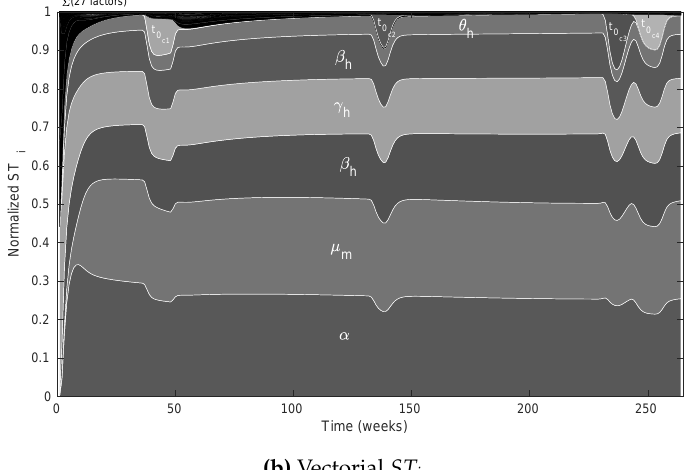
Figure 5. Sensitivity analysis for the dengue model with four pulse-type inputs for case C (with 1% uncertainty in each nominal parameter), using ( a ) scalar and ( b ) vectorial ST i indices from the Saltelli